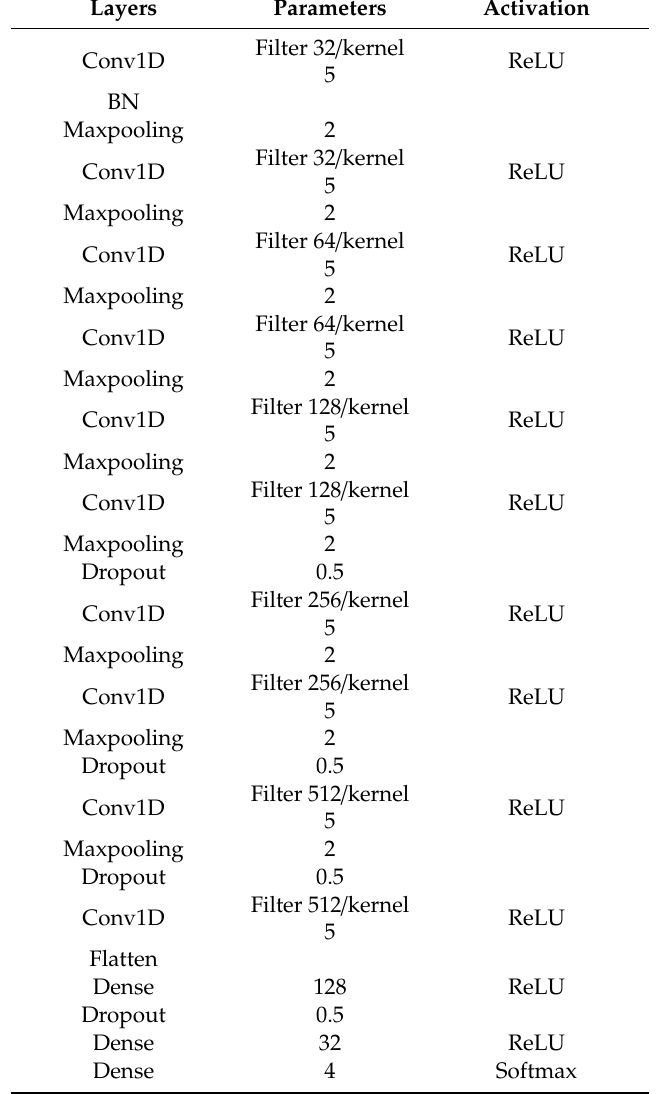
Table 1. Parameters of each layer of proposed 1D convolutional neural network